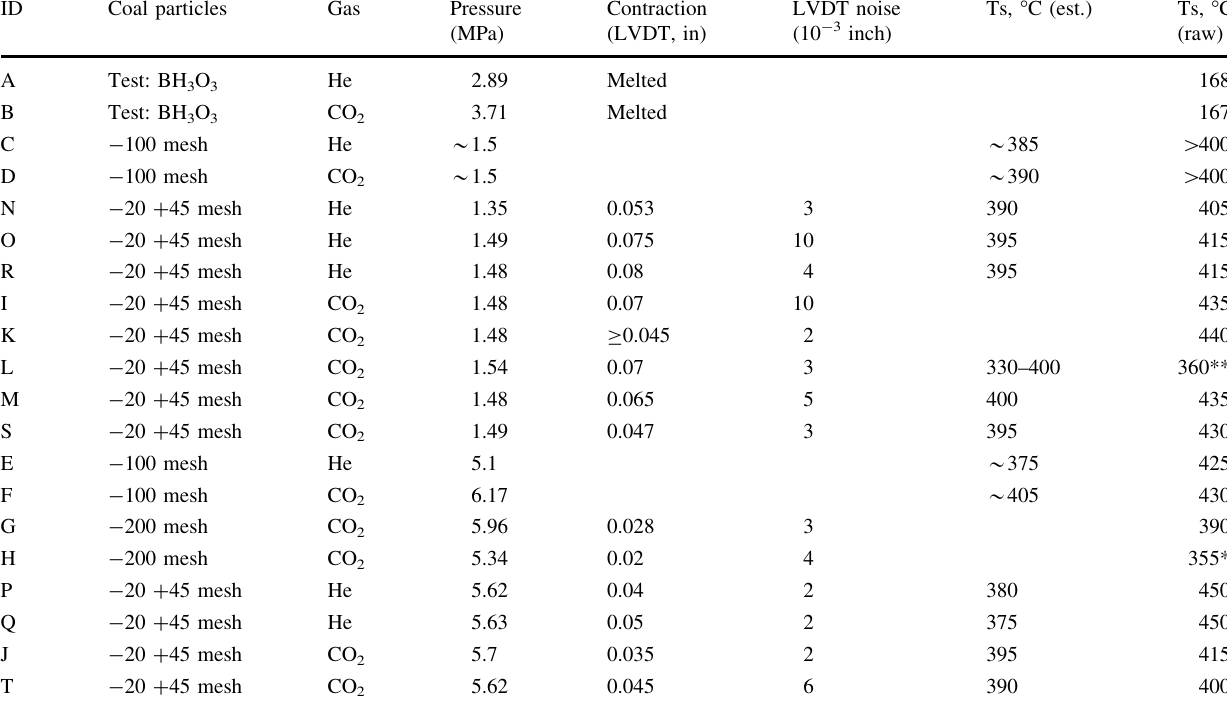
Table 2 Summary of the softening temperature (Ts) measurements on Pocahontas No. 3